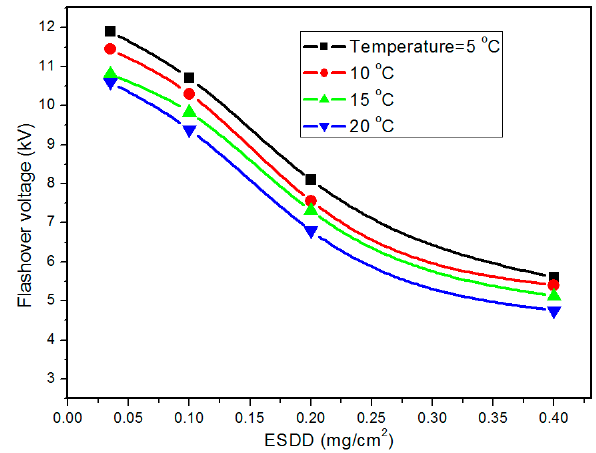
Figure 15. Flashover voltage at different temperature, where pollution distribution = uniform, NSDD = 0.75 mg/cm 2 , humidity level = low, and standard deviation = 3.3%–6.8%.